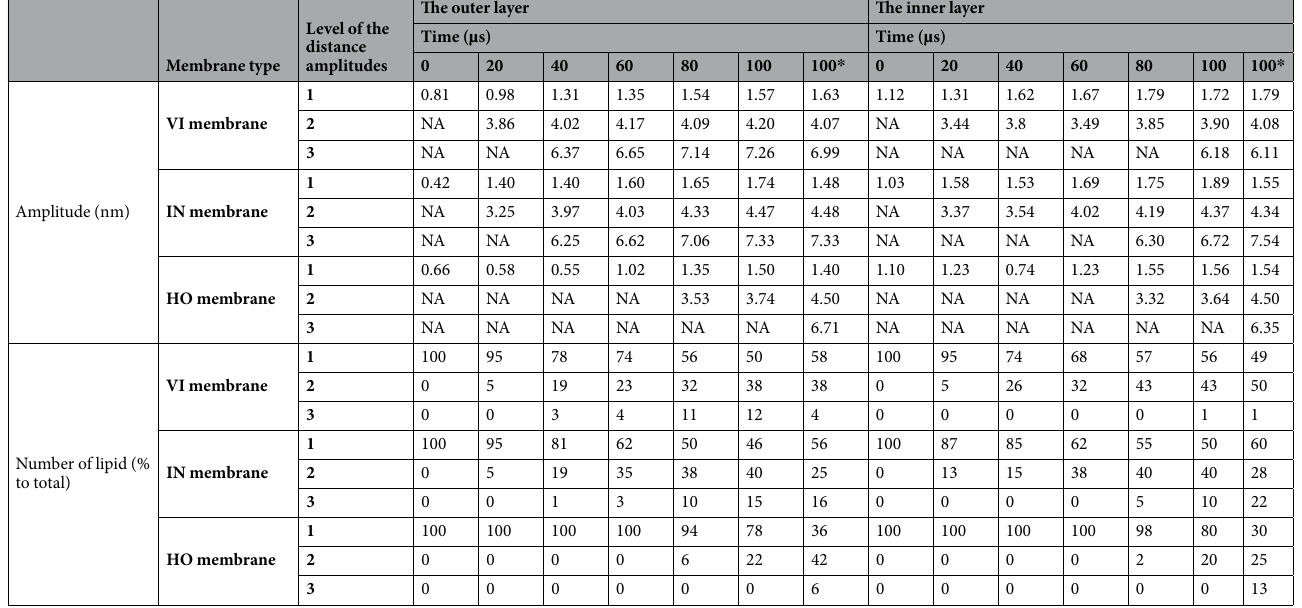
Table 1. Development of membrane perturbation induced by the binding of kB1. * The distance amplitudes are measured using the second simulation condition. NA: not